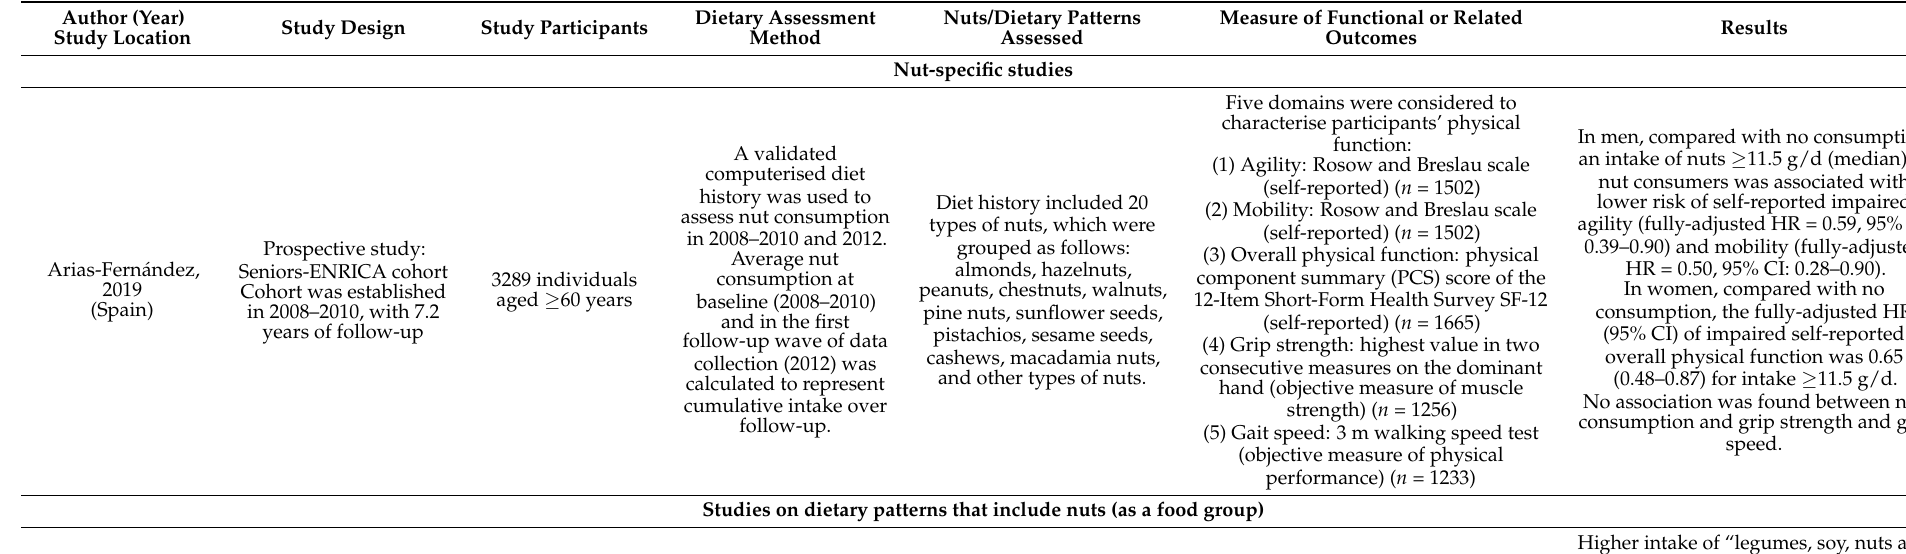
Table 2. Studies on nuts and sarcopenia related